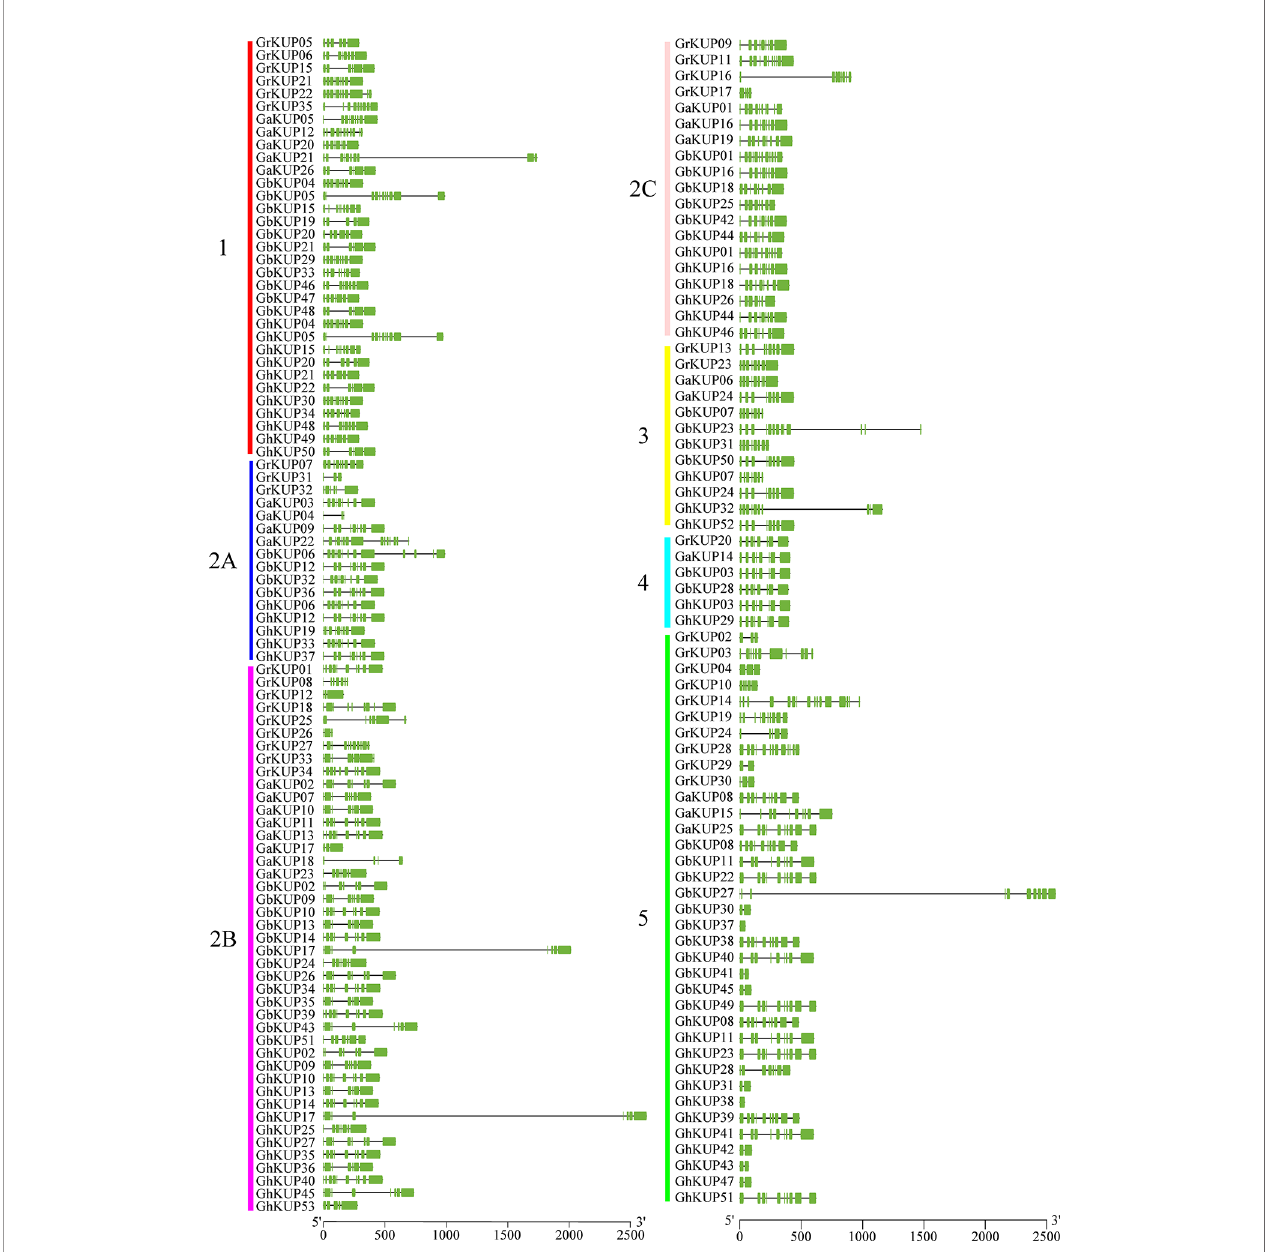
FIGURE 4 | Gene structural analysis of the KUP family in G. raimondii, G. arboreum, G. barbadense , and G. hirsutum . The green box and the black line represent the exon and intron, respectively. KUP subfamilies are indicated by different colors and letters. The gene structural location can be estimated by using the scale at the bottom of the fi